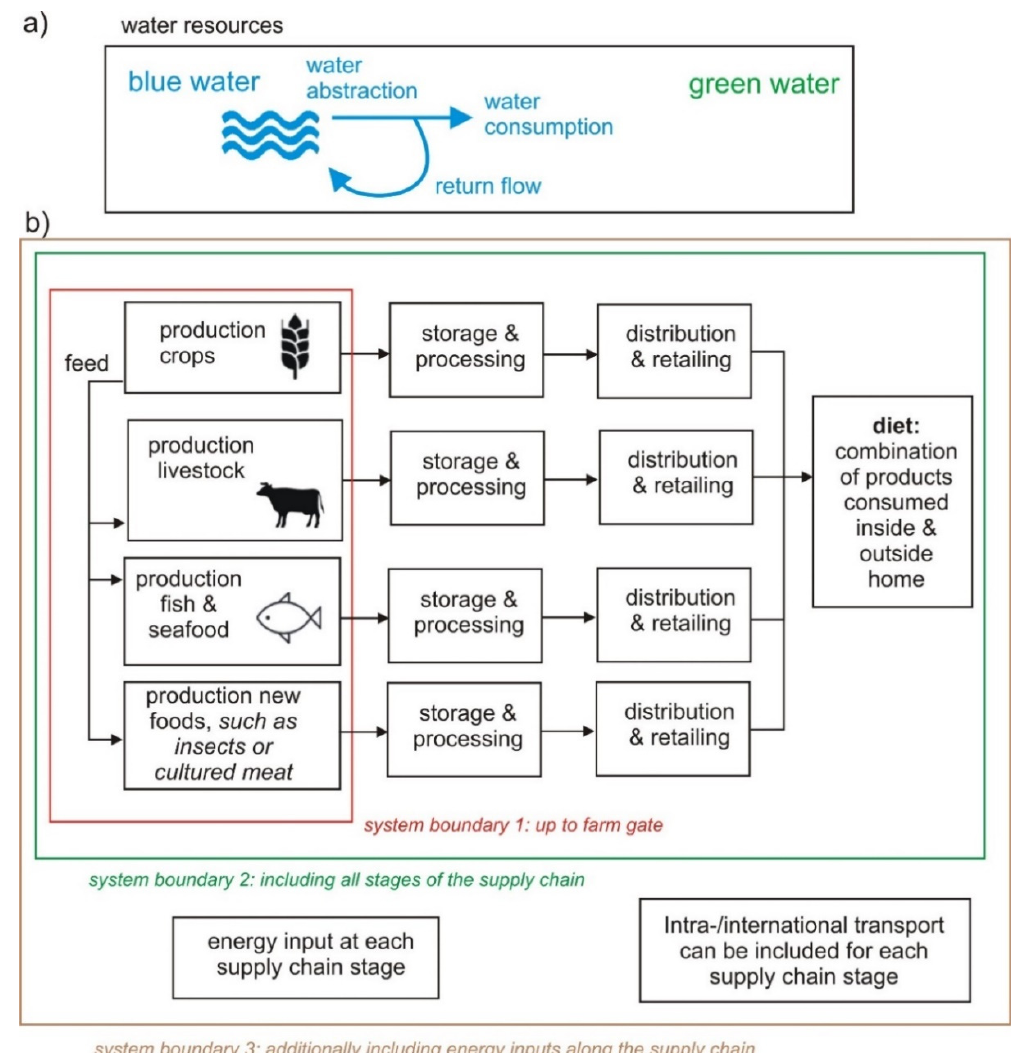
Figure 1. Representation of ( a ) water resources relevant for providing a healthy diet; ( b ) the supply chain of food products providing a healthy diet, with a selection of three relevant and common system boundaries used to quantify water resources required to produce a diet.